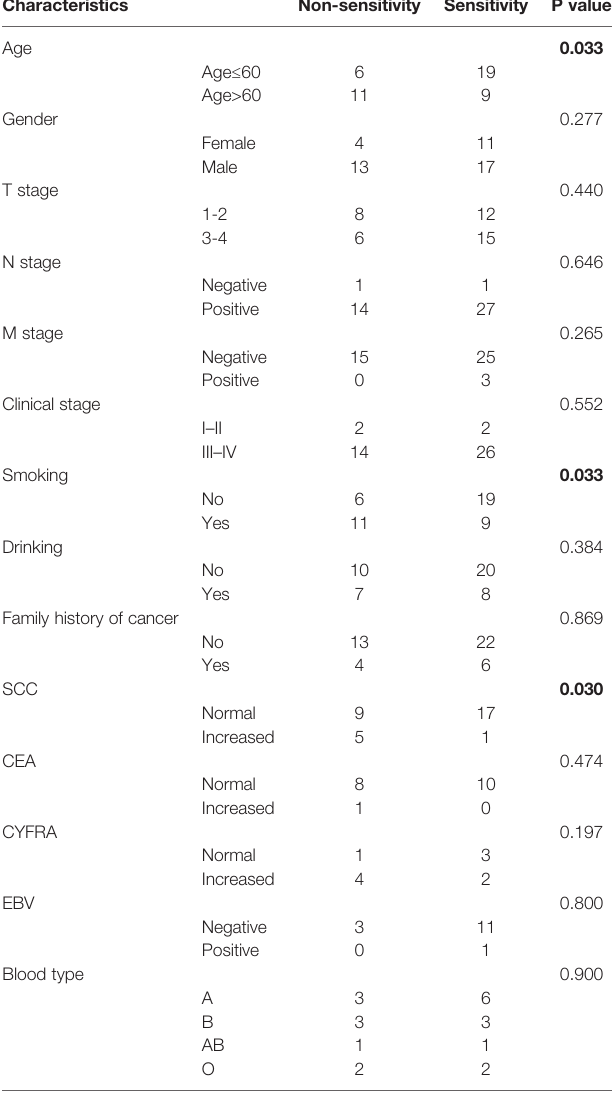
TABLE 5 | Association of clinicopathological parameters with radiotherapy sensitivity of HNSCC patients.